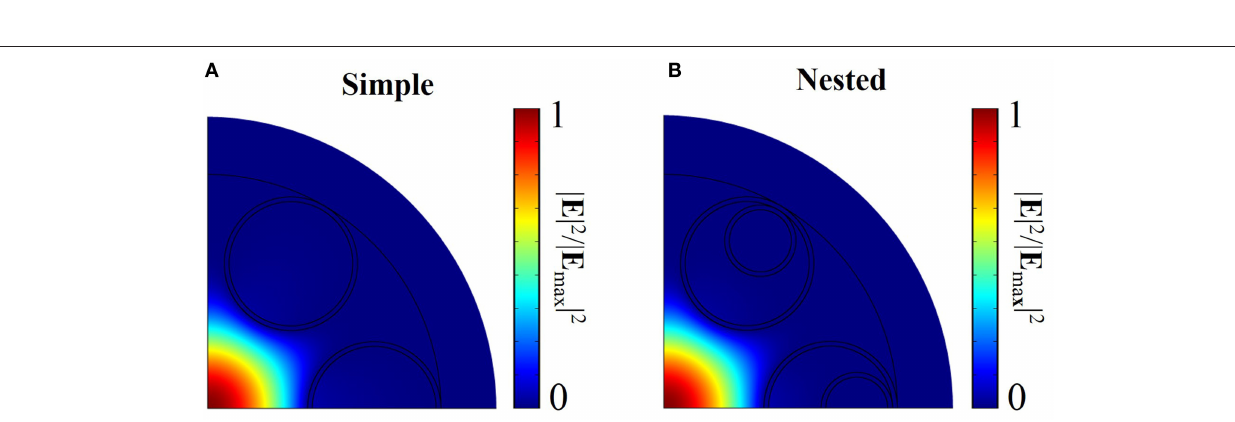
FIGURE 5 | Normalized mode intensity at a wavelength of 2.00 µ m in both (A) simple and (B) nested negative curvature fibers.